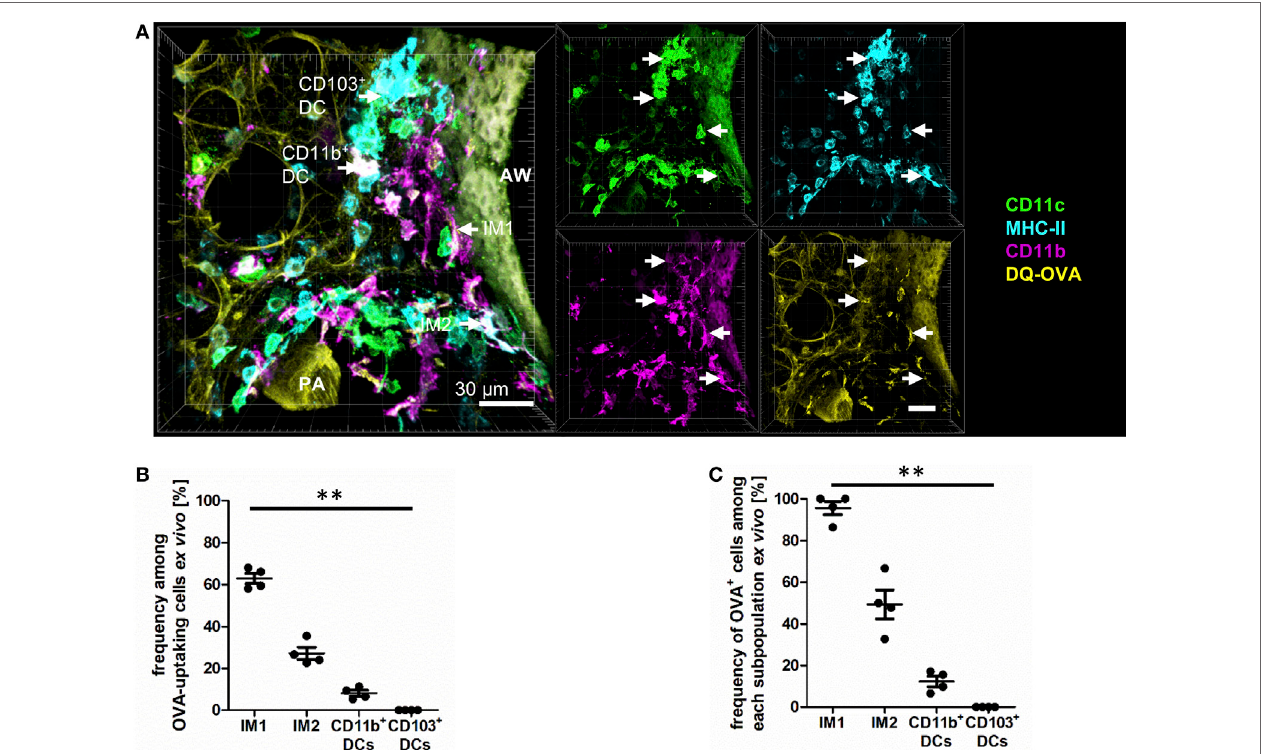
FigUre 5 | Interstitial macrophages (IM)1 and IM2 are major antigen-uptaking cells in the lung in vitro . Precision cut lung slices (PCLS) (300 µm) from naive C57BL/6 mice were generated and incubated in vitro with 100 µg house dust mite extract (HDM) mixed with 40 µg DQ-ovalbumin (OVA). After 30 min of incubation, PCLS were fixed and stained with anti-CD11c, anti-MHC-II, and anti-CD11b mABs. Stained slices were evaluated with confocal microscopy. Fluorescence of DQ-OVA was measured in the FITC-channel. (a) Single-color and merged color display with CD11c (orange), MHC-II (red), CD11b (blue), and DQ-OVA (green). Data are representative of four independent experiments. (B) Frequency of IM1, IM2, CD11b + conventional DCs (cDCs), and CD103 + dendritic cell (DCs) among OVA-uptaking cells. (c) Frequency of DQ-OVA + cells within each phagocyte subset. Lines indicate mean ± SEM. Differences between groups were tested by Kruskal–Wallis test (B,c) for significance; ** p <